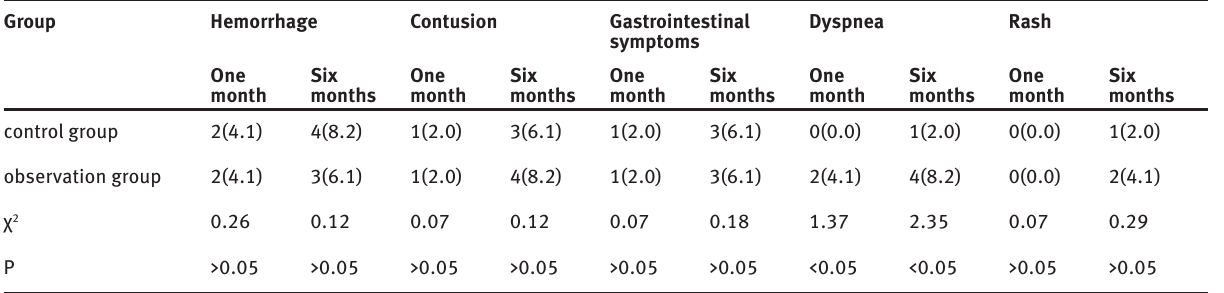
Table 5: Comparison of Adverse Reaction Incidence between two groups after PCI Group